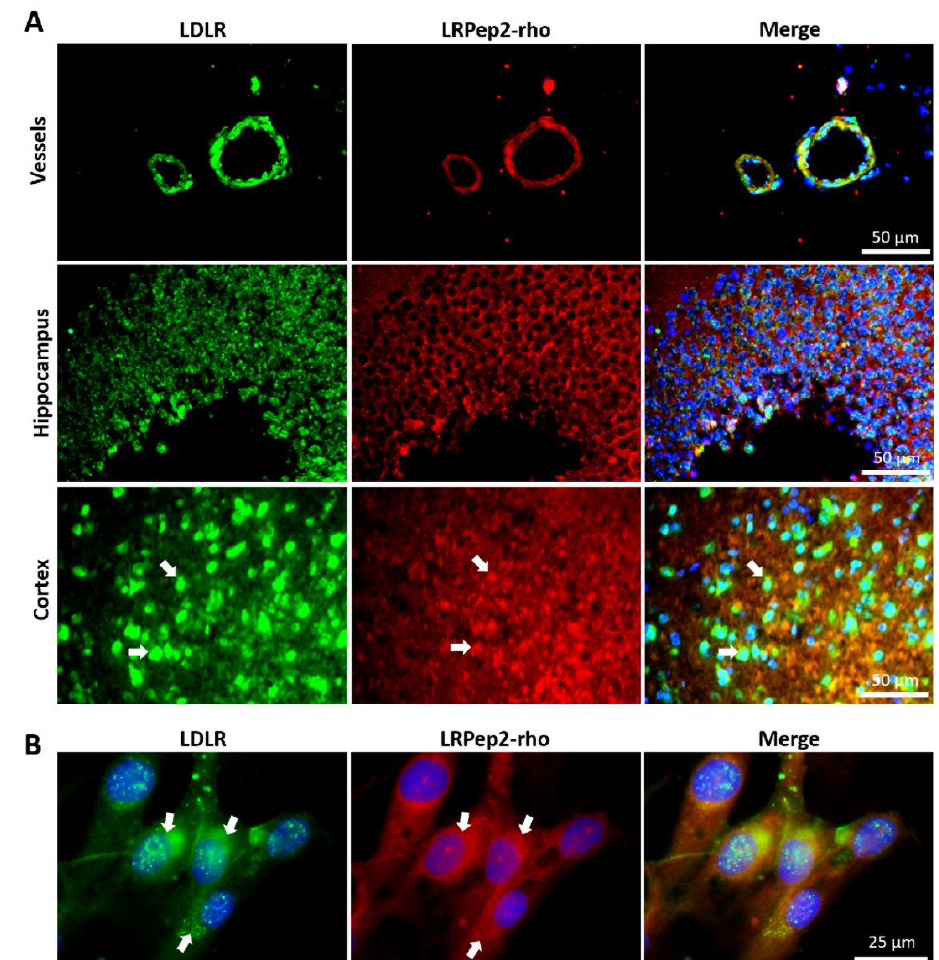
Figure 5. Colocalization of LRPep2-rho with LDLR on mouse brain slices ( A ) and ACBRI376 cells ( B ). LRPep2 appears in red due to the coupled rhodamine, LDLR is stained in green with fluorescein, and nuclei in blue with DAPI. White arrows highlight examples of colocalization areas.